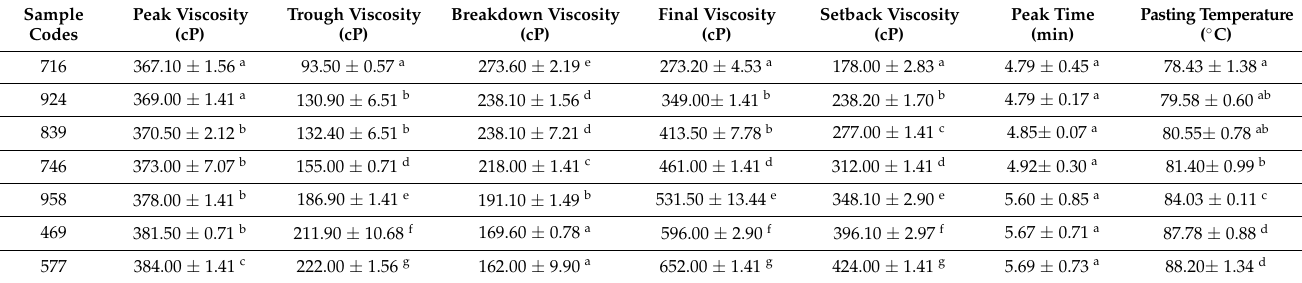
Table 3. Pasting properties of fermented millet “ Ibyer ” beverage enhanced with ginger powder. Sample Codes